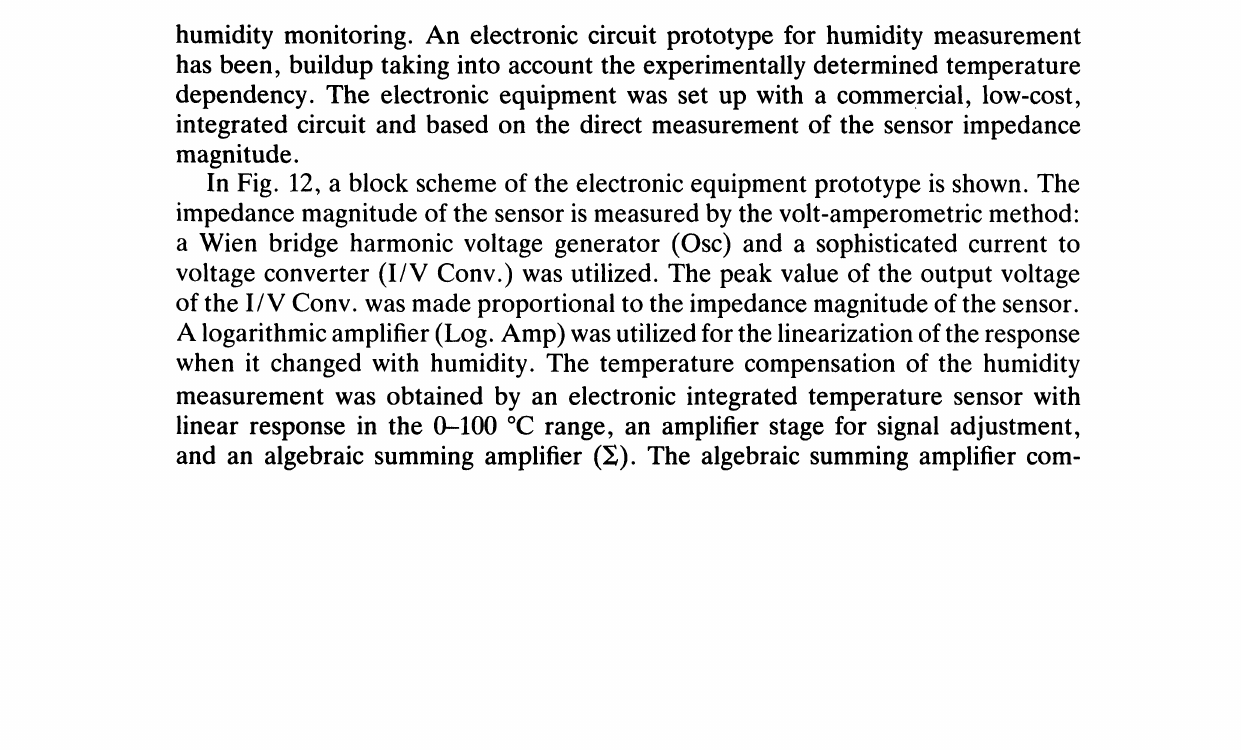
AGEING CYCLES FIGURE 9 Impedance values in saturated salt solution after aging cycles (21 days